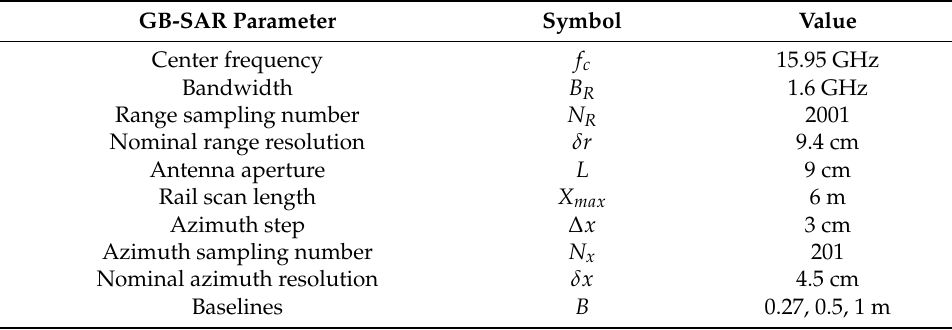
Table 1. System parameters for a bistatic GB-SAR